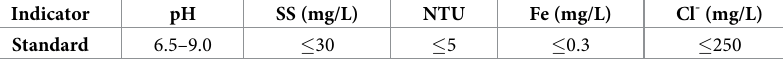
geted the management of an agricultural irrigation water system. The socio-economic effi- ciency of a water resources system is mainly influenced by the latter’s water resource use patterns and adjustment measures, which are controlled by human activities and the develop- ment of society and the economy [60]. Therefore, the selection of indicators is context-depen- dent and should be tailored to the actual situation of a given study area.